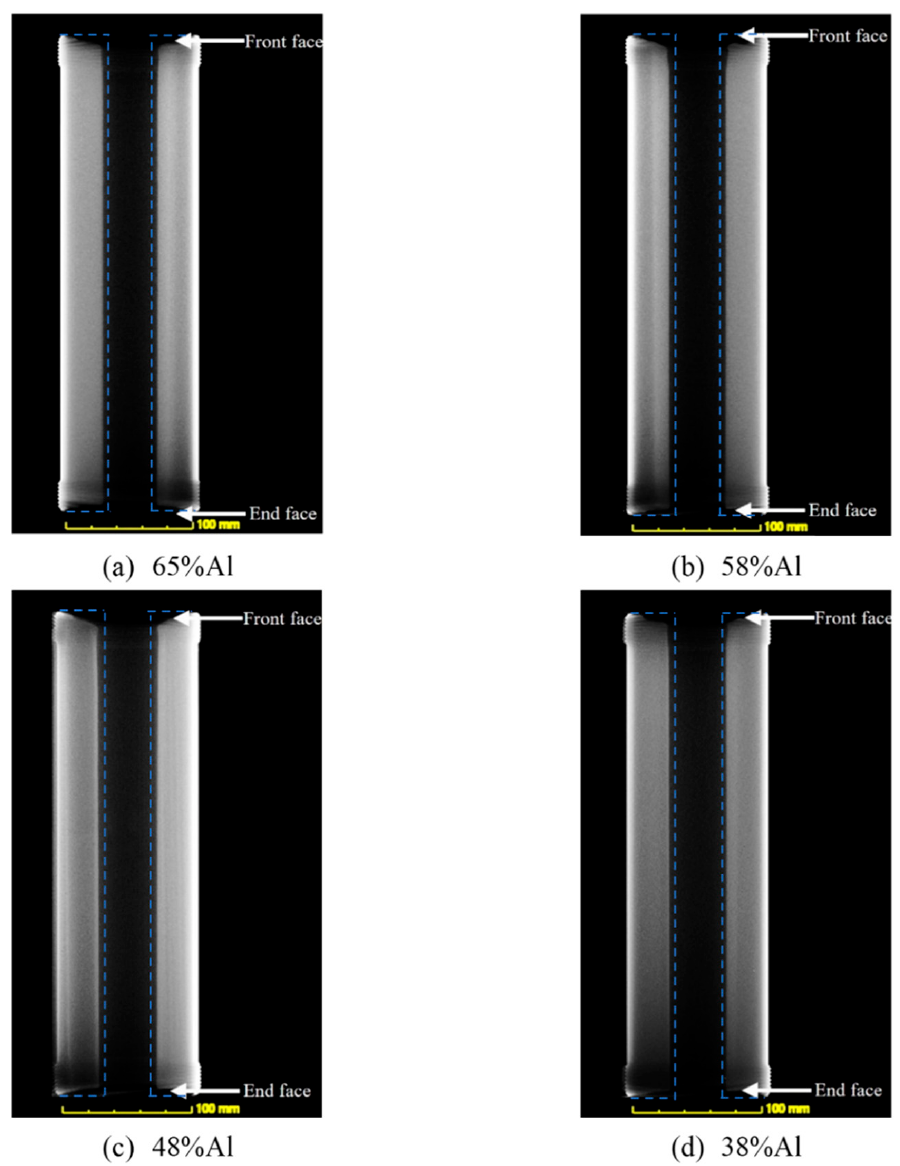
Figure 6. CT scan images of the grains after the test.